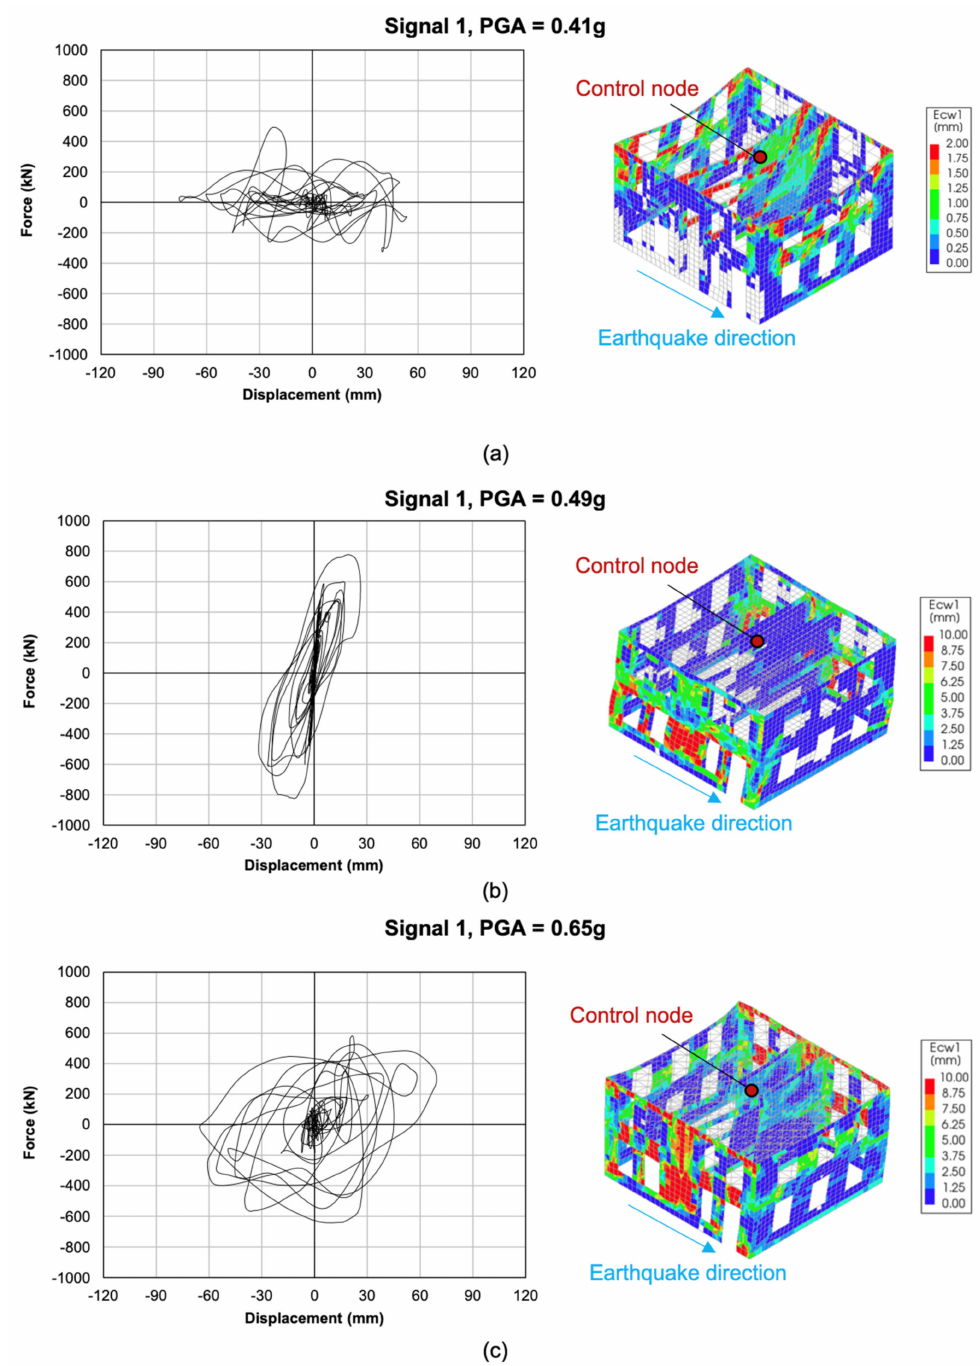
Figure 13. Base shear vs. top roof displacement response and damage level in terms of the principal crack opening (Ecw1) for the three configurations: B2-AB ( a ), B2-RC ( b ), and B2-PP ( c ) at a near-collapse